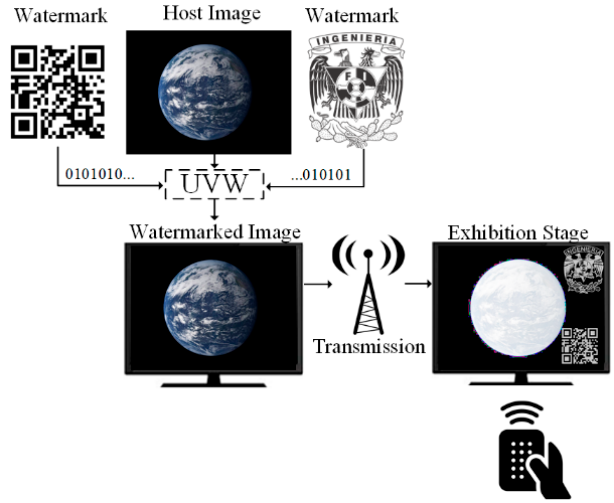
Figure 1. General diagram of the UVW.